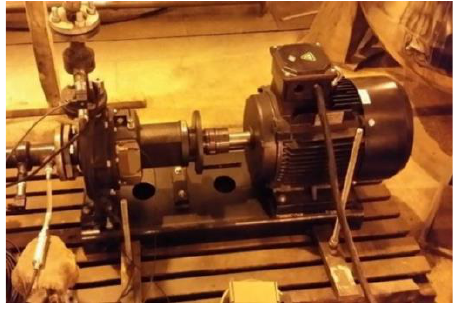
Figure 16. The model pump [78].